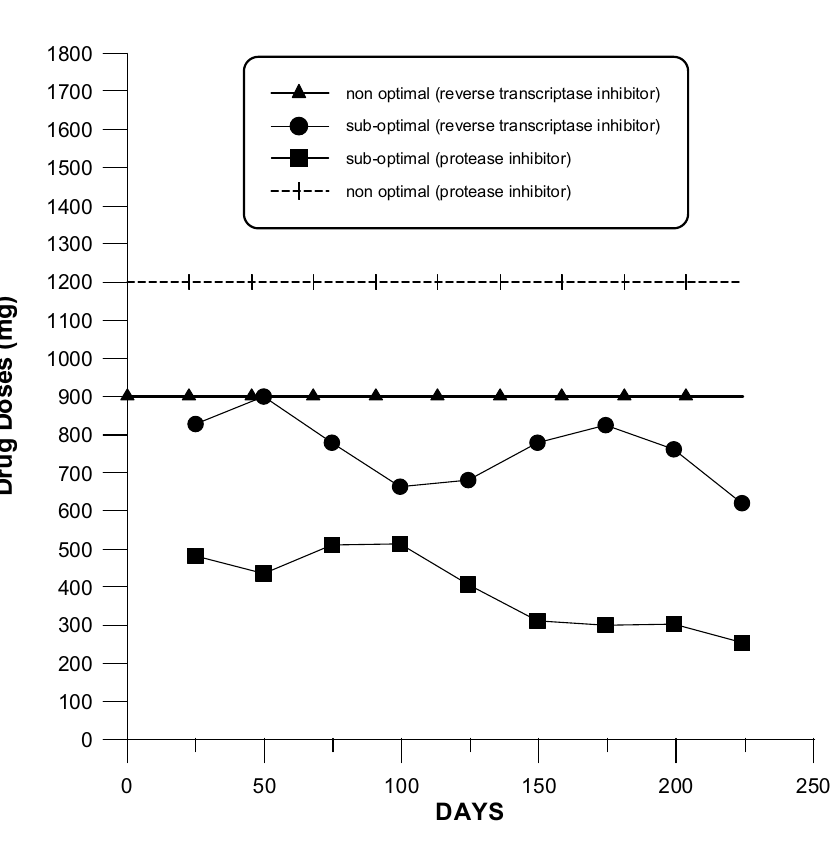
Fig. 2 – Drug doses used in the computer